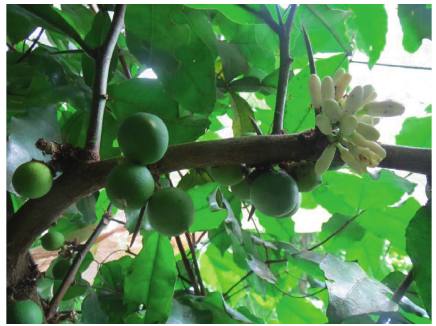
Figure 2: Flowers and unripe fruits of C. articulata .